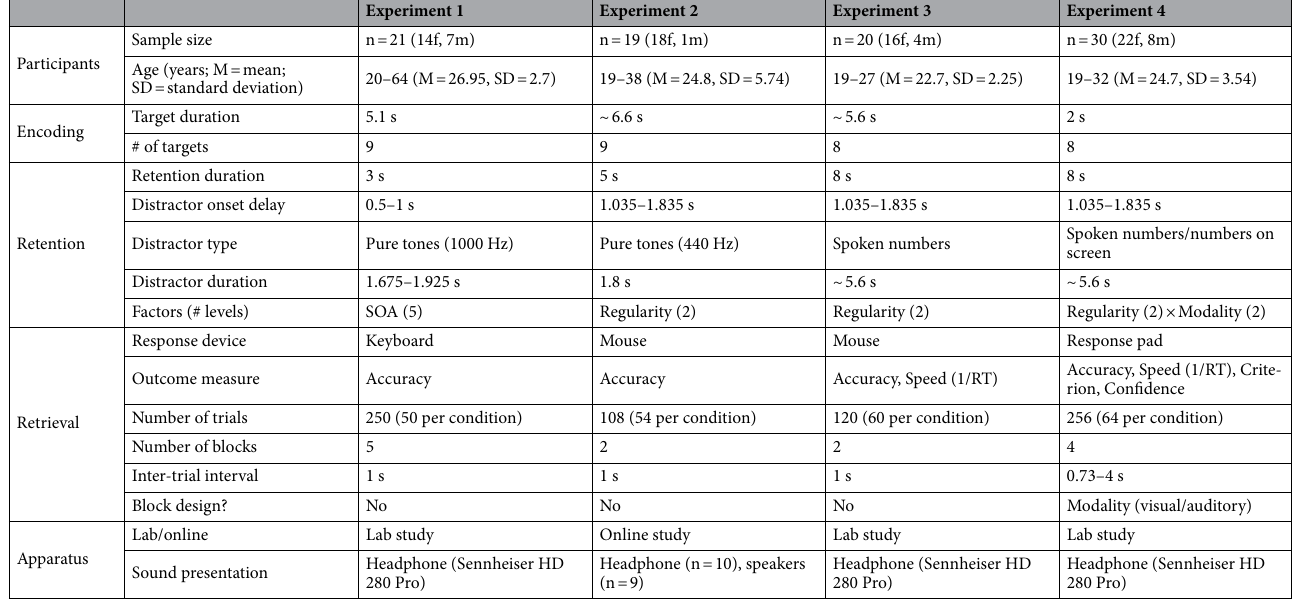
Table 1. Details of experimental manipulations for each experiment. m male, f female, # number, n sample